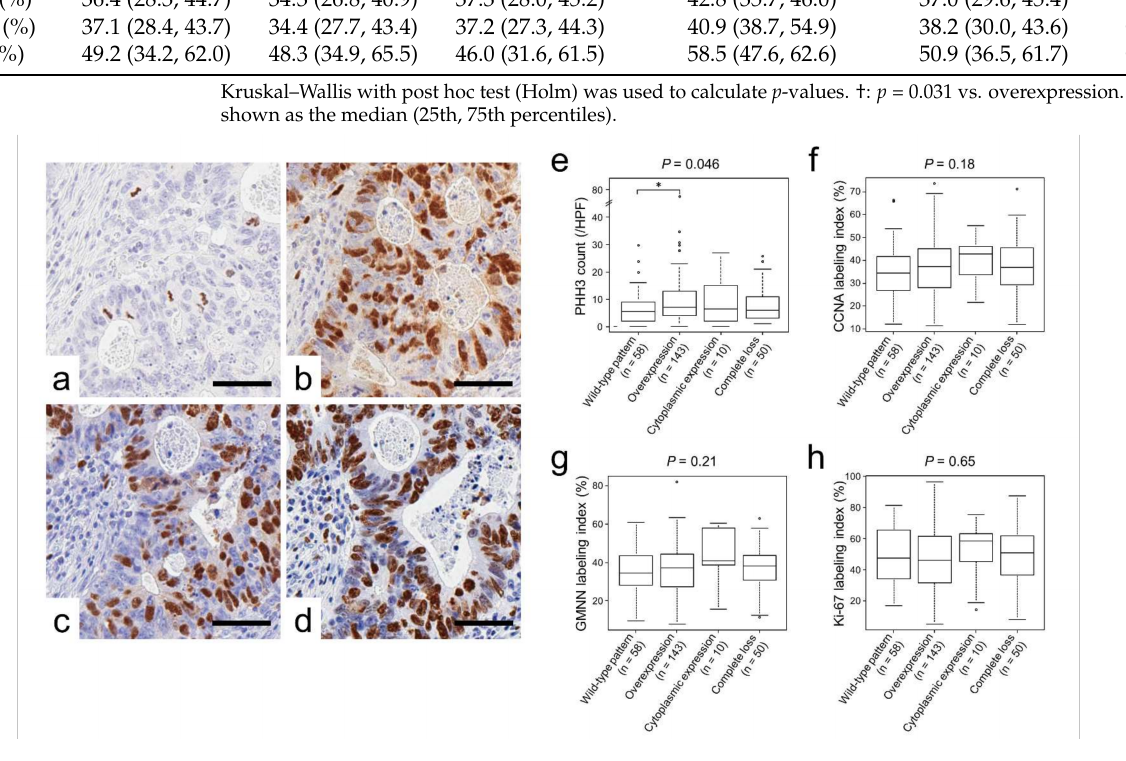
Figure 3. Cellular proliferation marker expression classified according to p53